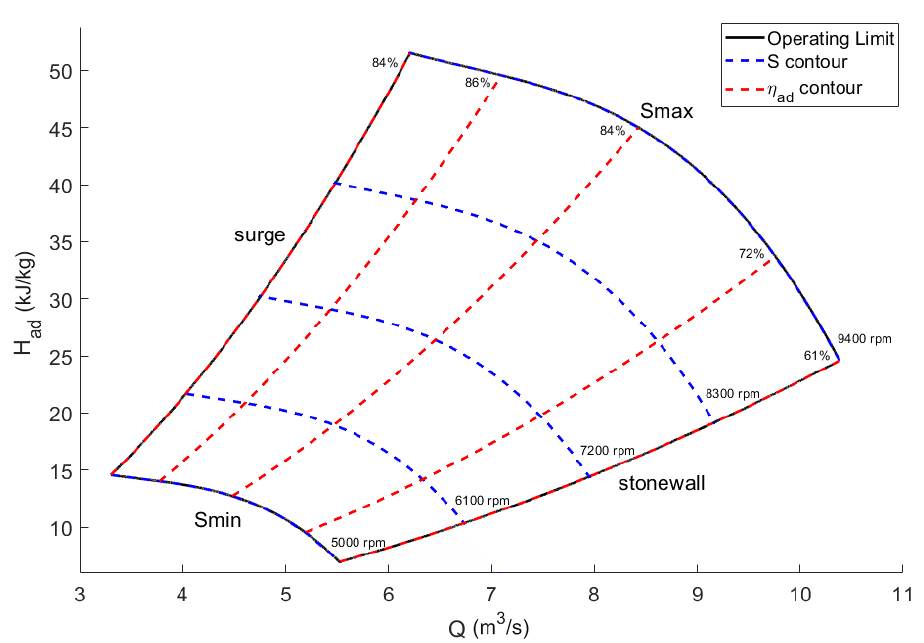
Figure 4. Typical operating envelop of a centrifugal compressor unit, with compressor speed and efficiency contours